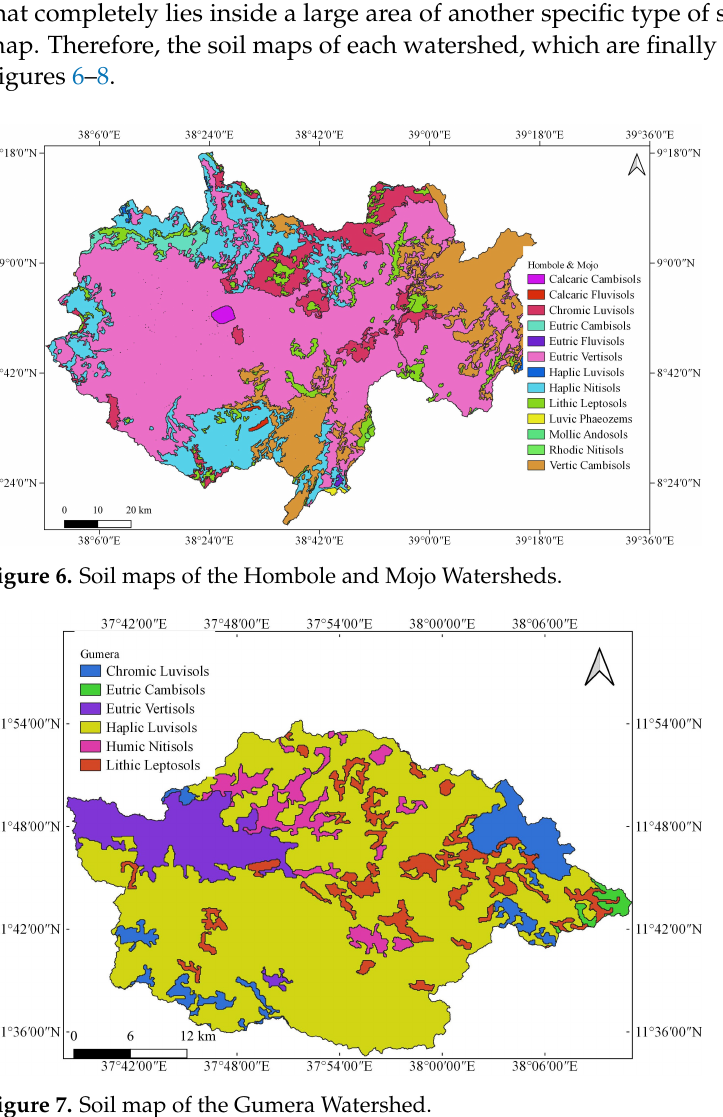
Figure 7. Soil map of the Gumera